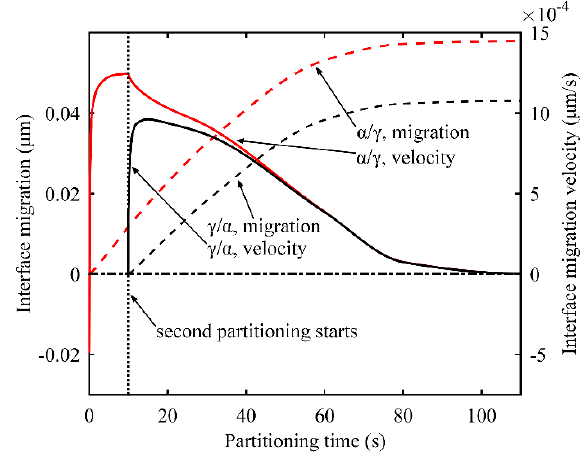
Figure 13. Evolution of interface migration and interface migration velocity during the first and second partitioning (two-stage Q-P process). The positive direction of the interface migration points from martensite to austenite. The parameters for the process are: T Q1 = 325 ◦ C, T P1 = 425 ◦ C and the partitioning time is 10 s; T Q2 = 250 ◦ C, T P2 = 350 ◦ C and partitioning time is 100 s.